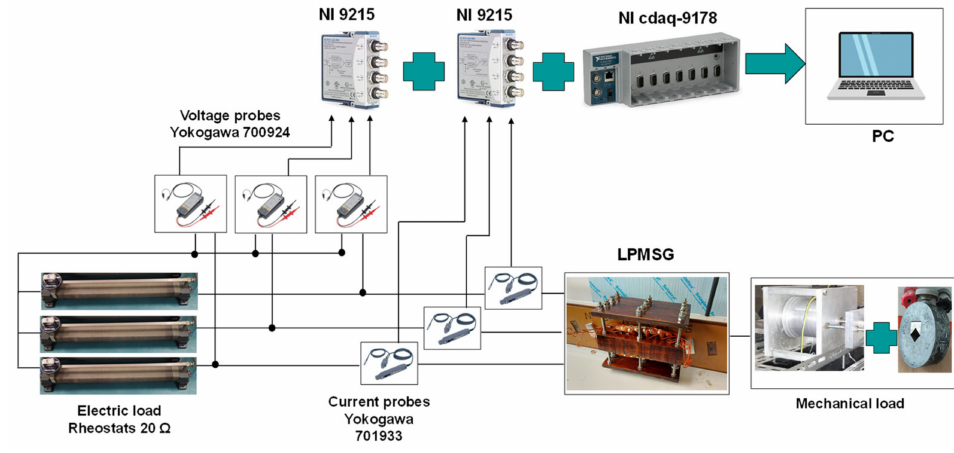
Figure 7. Schematic representation of the measurement system.